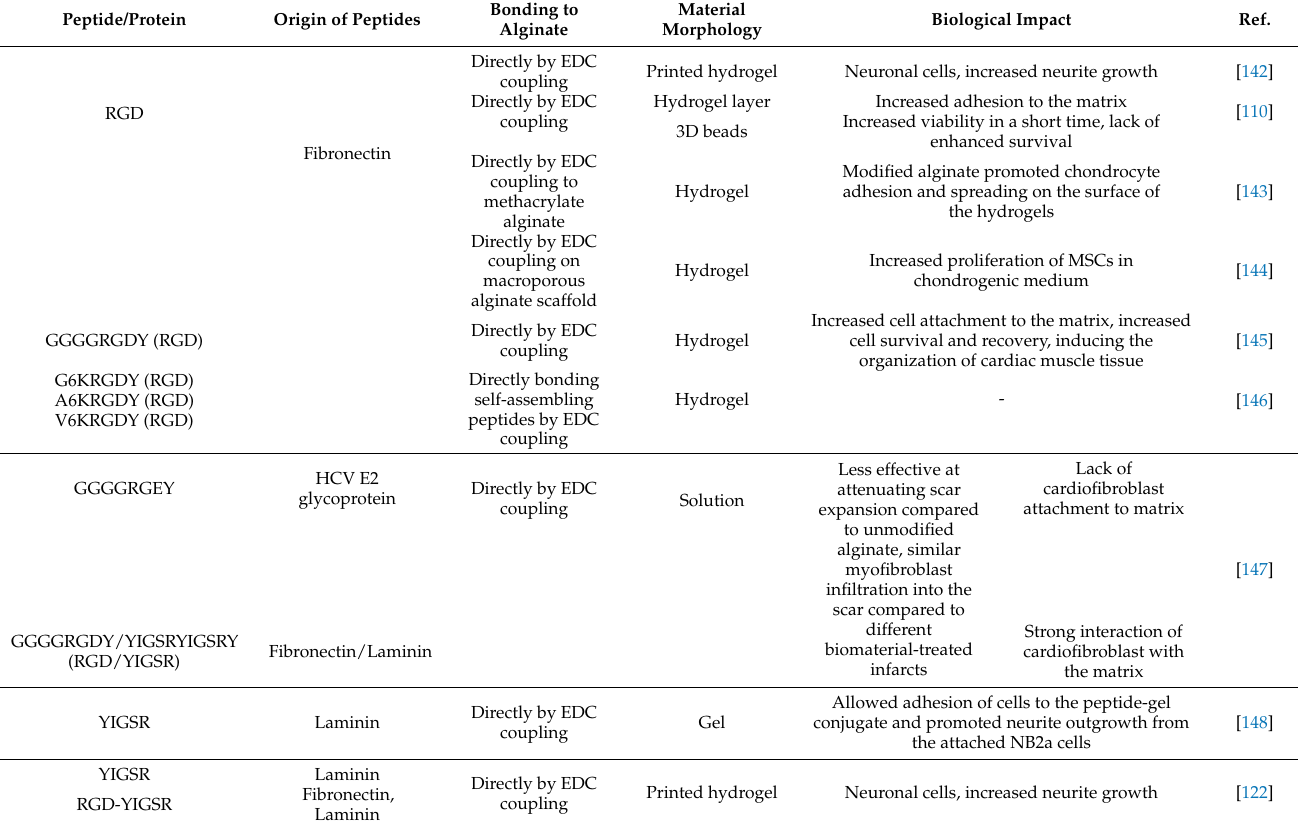
Table 5. Summary of studies on the biological activity of alginate-peptide/protein conjugates.